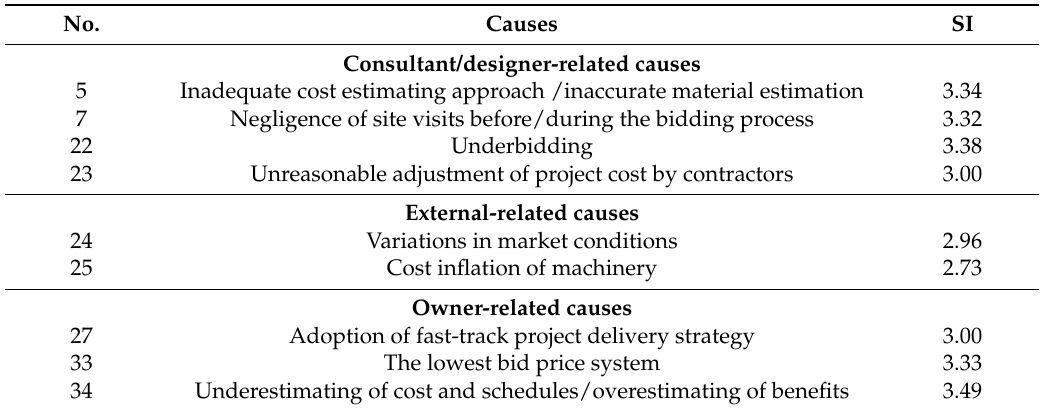
Table 4. Causes of cost